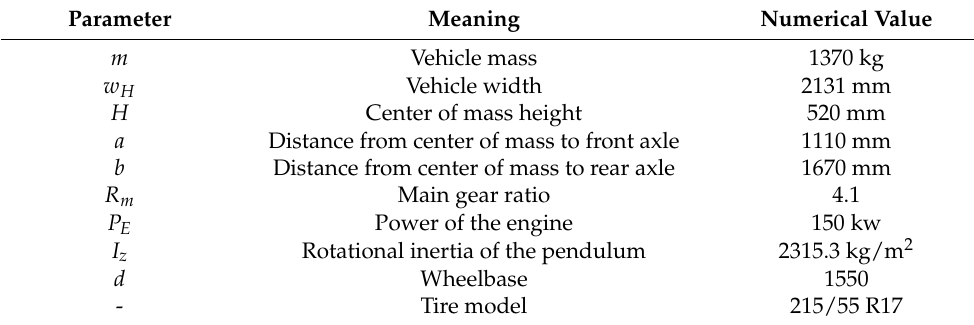
Table 1. Selected parameters of the simulation